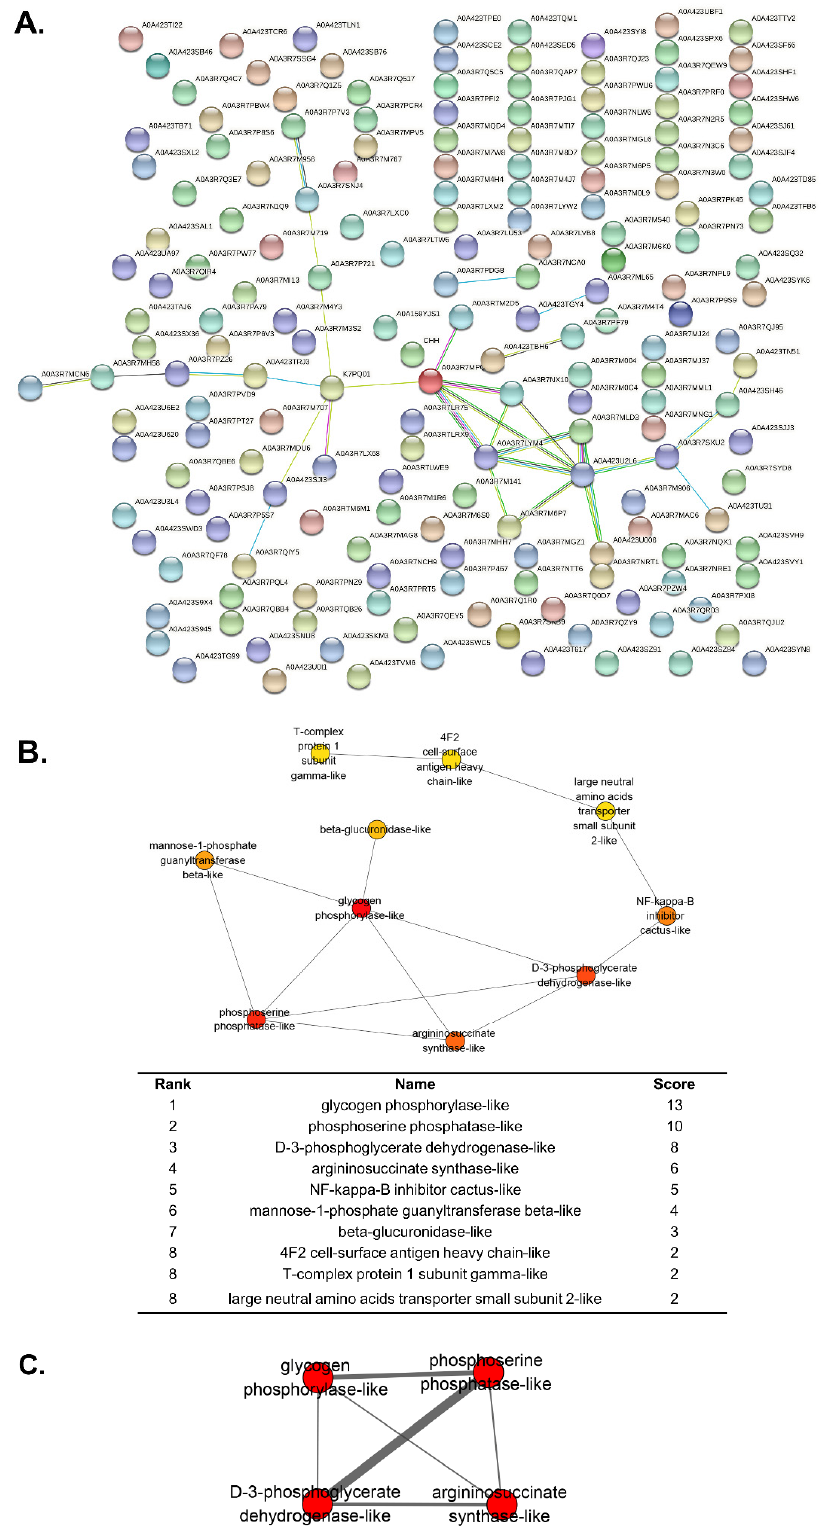
Figure 6. Protein–protein interaction (PPI) network. ( A ) STRING analysis of the identified DEGs. ( B ) The top 10 Hubba nodes ranked by maximum clique centrality (MCC). ( C ) Subnetworks with MCODE score of